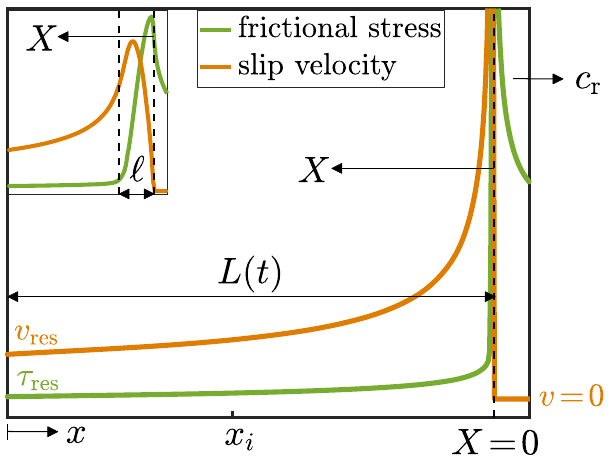
Fig. 2 The near-edge fi elds of a rupture front propagating along with a rate-and-state frictional interface. A frictional rupture front that nucleated at x = 0 and propagates to the right in a 2D anti-plane rate-and-state- friction simulation (its symmetric counterpart, propagating to the left, is shown in Fig. 3a of ref. 23 , see details about the computer simulation therein). Its instantaneous half-length is L ( t ) and the instantaneous propagation velocity is c r ( t ) ≃ 0.94 c s . Shown are the frictional stress (strength) fi eld τ ( X ; c r , L ) (green) and slip velocity fi eld v ( X ; c r , L ) (orange) left behind the propagating edge. Here, X ( t ) is a coordinate moving with the edge and pointing backward (cf. Fig. 1), whose origin ( X ( t ) = 0) is de fi ned according to v = 0. The two fi elds approach fi nite residual values, τ res and v res , respectively, far behind the propagating edge. (inset) A zoom in on the edge region, revealing a localization lengthscale ℓ associated with edge- localized dissipation, resulting in an effective fracture energy G c (see Fig. 3a, for a precise de fi nition of ℓ ). v ( x , t ) follows, to a very good approximation, the conventional square root singularity of linear elastic fracture mechanics (LEFM) at an intermediate region, i.e., X > ℓ and prior to approaching v res ( fi t not shown here, see ref. 23 ). The same conventional singularity is featured by τ ( X , t ) ahead of the edge, X < 0 and ∣ X ∣ > ℓ , but it is not discussed here 23